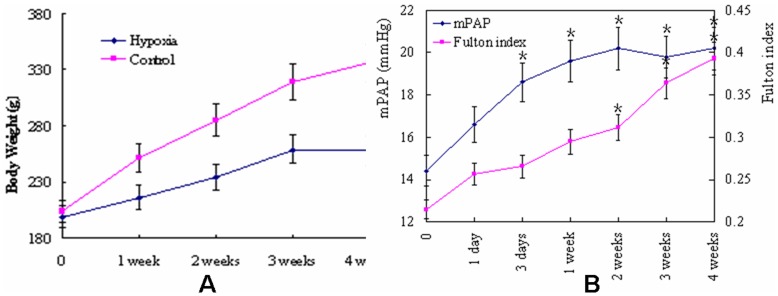
Validation of rat PH model induced by hypoxia.(A) weight changes in the course of hypoxia treatment. The results of F test showed that there were significant differences between the weights of experimental and control groups at each time points. The curve of weight changes in control rats is nearly a straight line, whereas the curve in model rats is nearly a quadratic function curve. (B) the changes of mean pulmonary artery pressures (mPAP) and the Fulton index in PH rats. ANOVA analyses revealed that mPAP and the Fulton index were significantly different in each points. With the increase of hypoxia duration, the mPAP in hypoxia rats increased with a peak at the second week, and maintained a high level until the end point. The continuous increase of Fulton index suggested progressive hypertrophy of rat right ventricle. (*, P<0.05 compared to control group, Data are expressed as means ± s.e.m.)